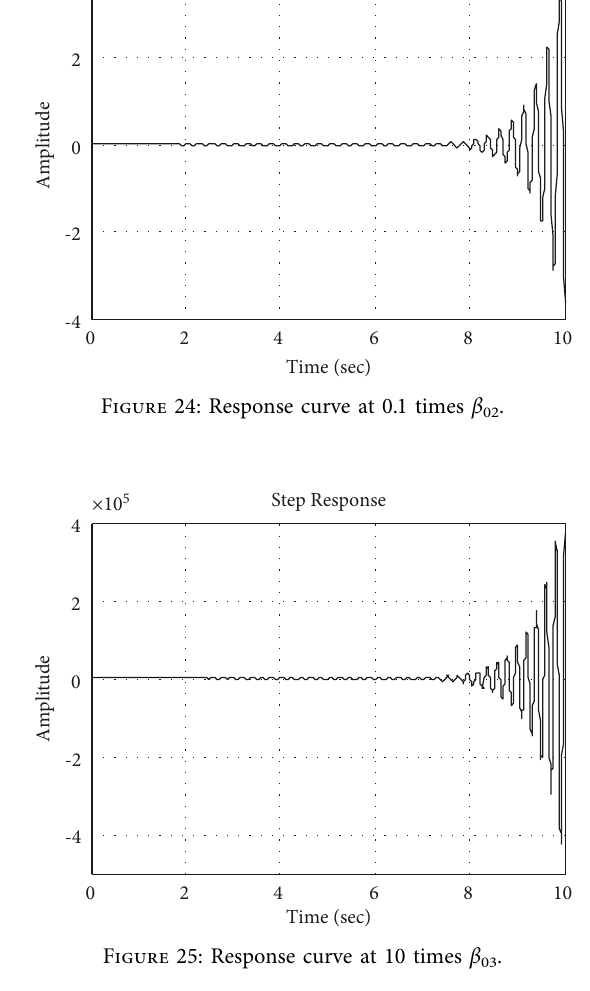
Figure 28: Response curve at 0.1 times β